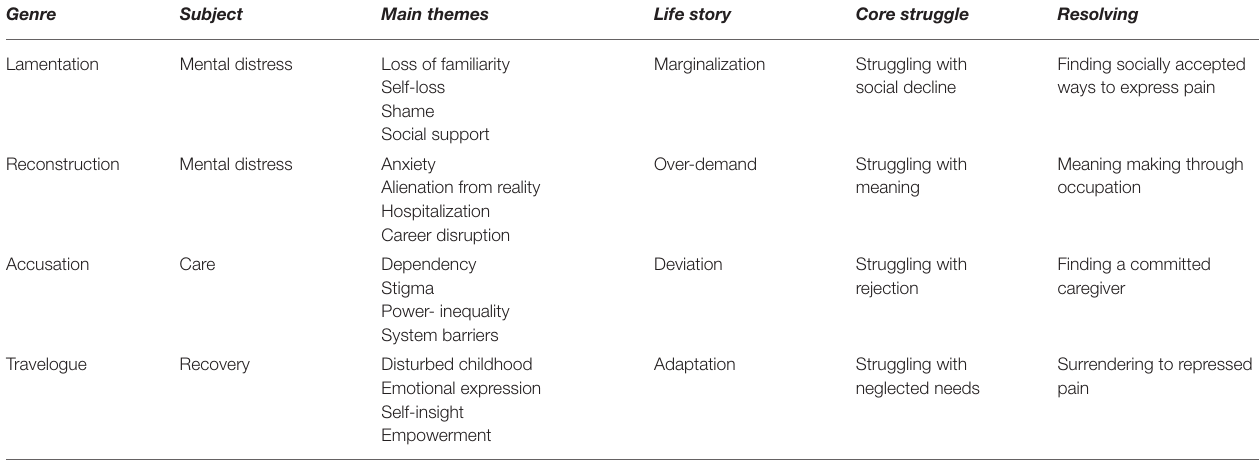
TABLE 3 | Syntheses of results on the personal